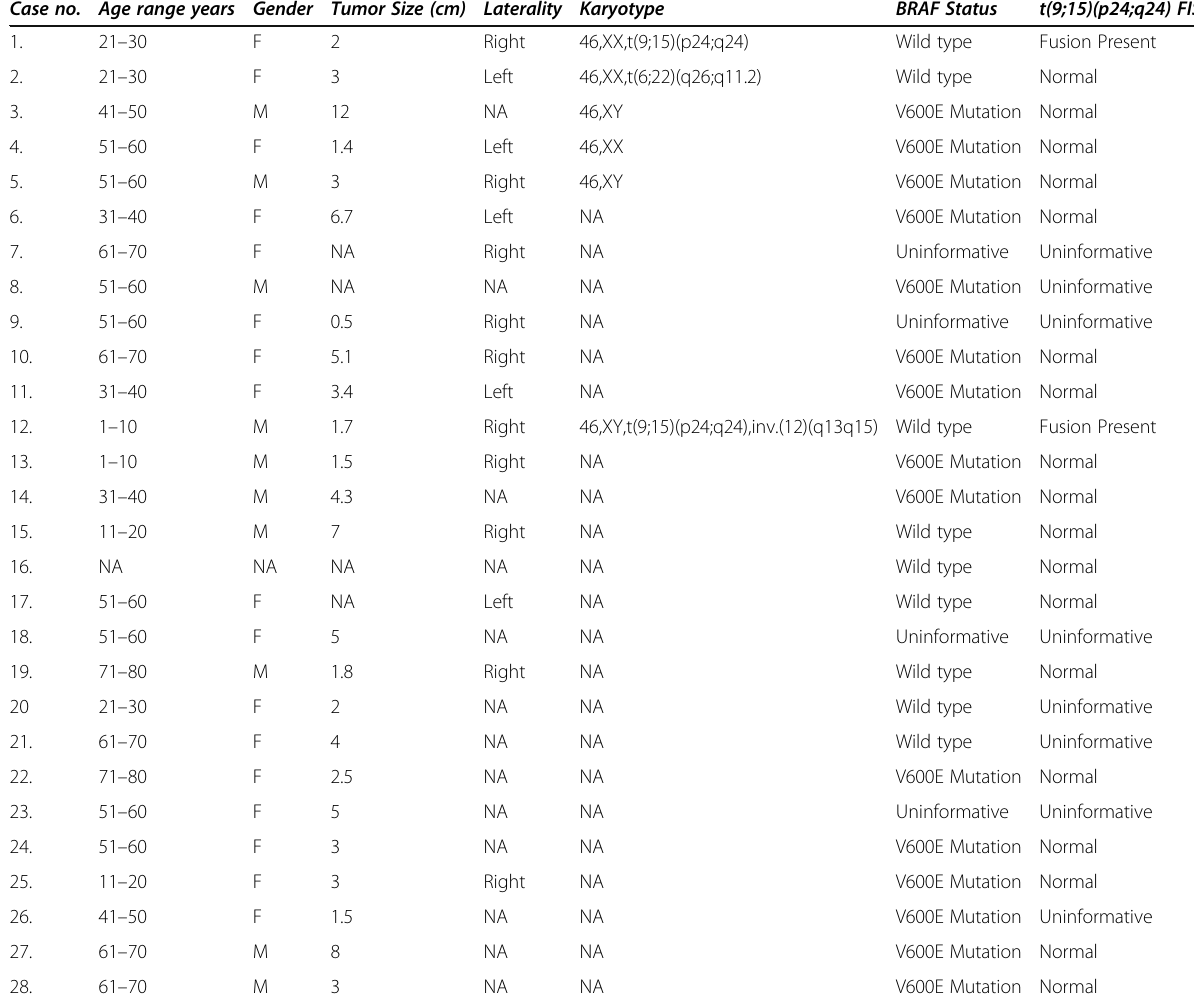
a Abbreviations : NA indicates not available, FISH Fluorescent in situ